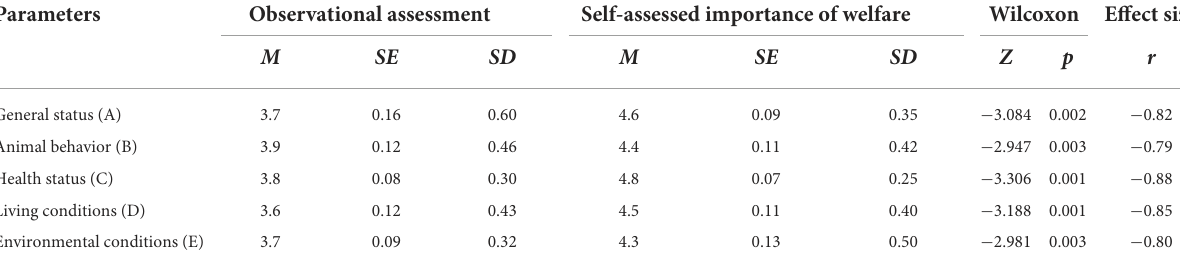
TABLE 3 Comparisons between observational assessment and self-assessed importance of animal welfare. Parameters